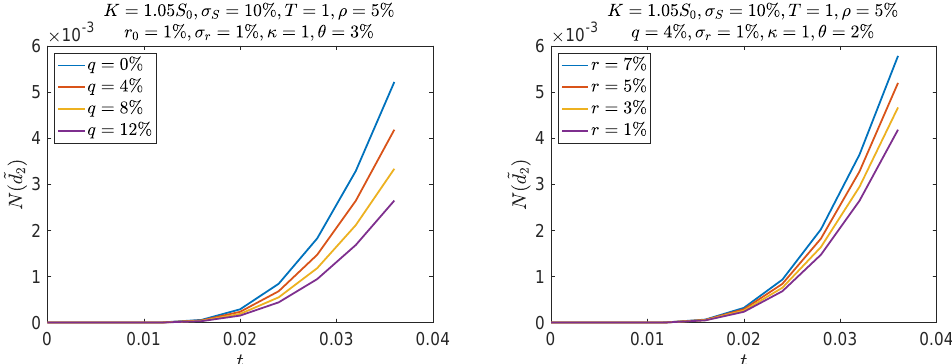
Figure 5. Probability that a call option on S in a stochastic interest rate framework is in the money at the first eight monitoring dates. Daily monitoring (250 dates for a T = 1 year maturity).